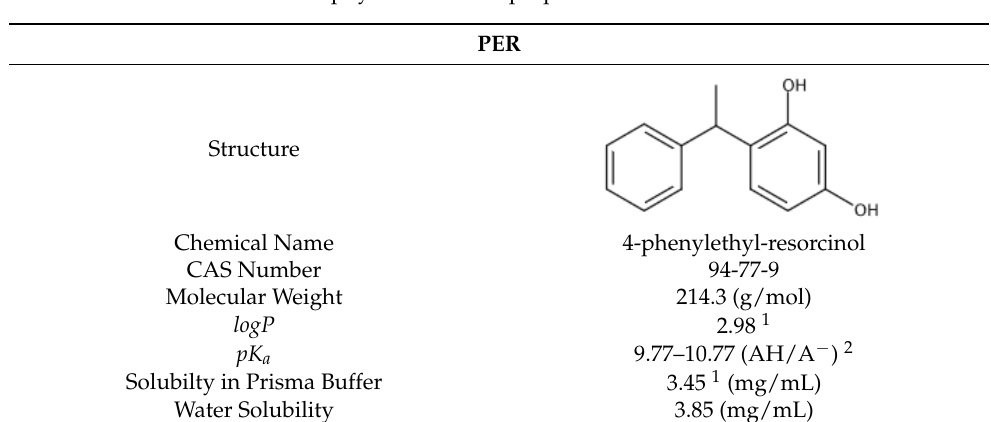
Table 2. Solvents used in the study and the solubility of PER in different solvents.